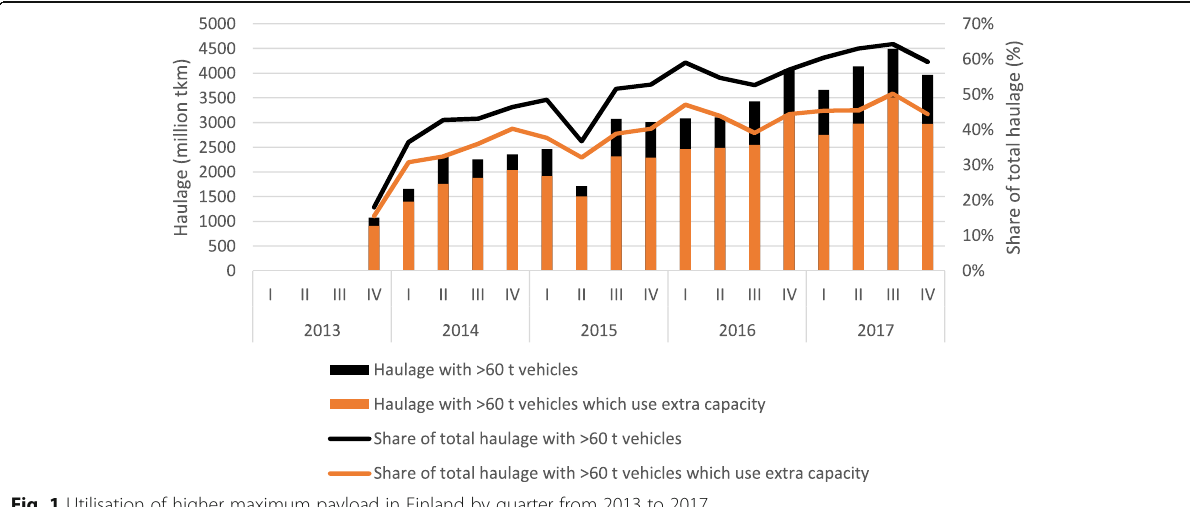
Fig. 1 Utilisation of higher maximum payload in Finland by quarter from 2013 to